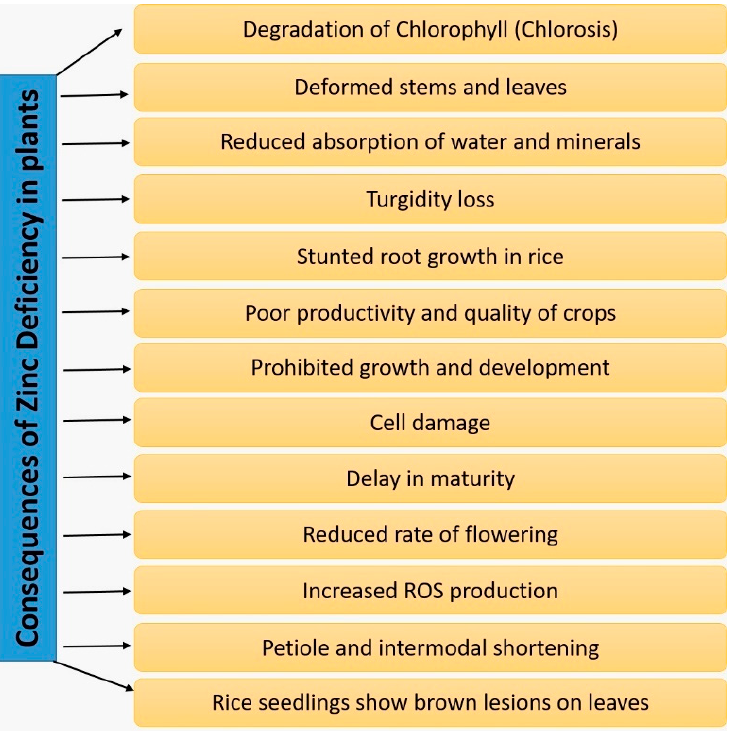
Figure 3. Deficiency effects of zinc in plants.